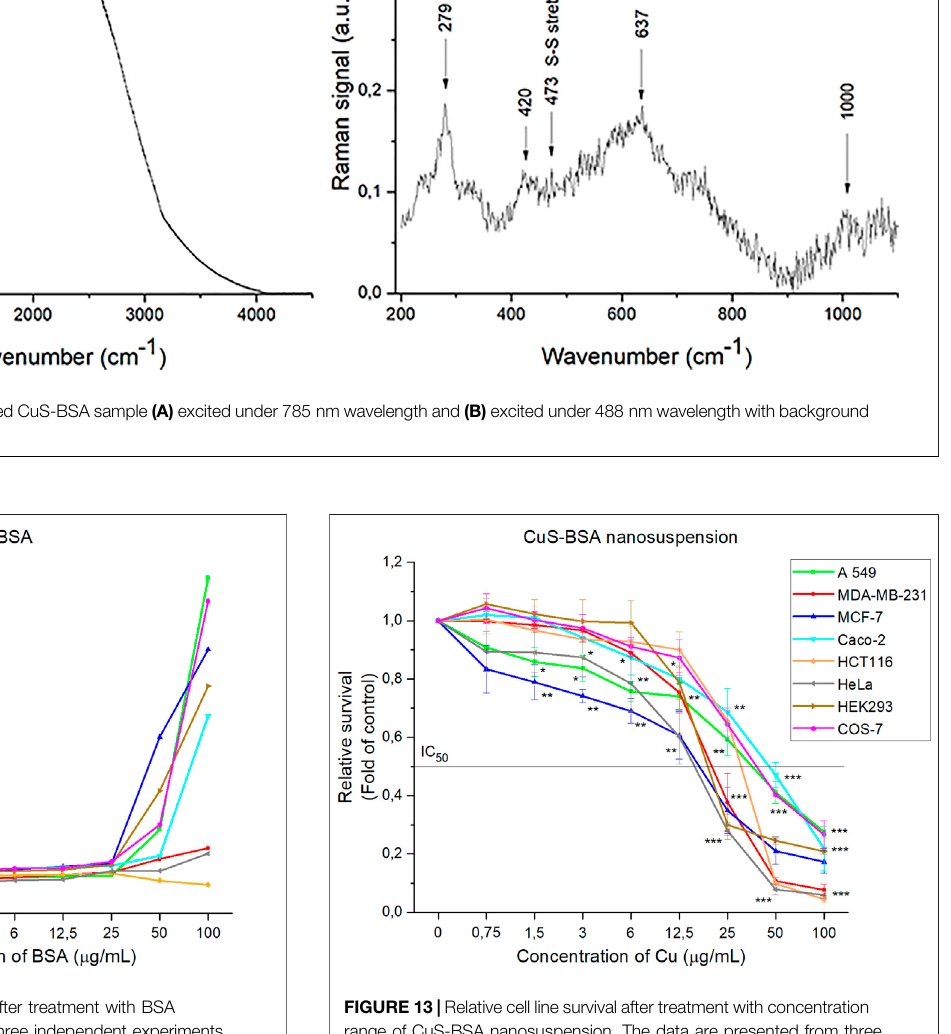
From a toxicological point of view, CuS-BSA nanosuspension could be suitable for future biomedical applications, but due to low cell selectivity, only a low dose which is non-toxic for non-tumor cell lines (copper concentration less than 3 μ g/ml